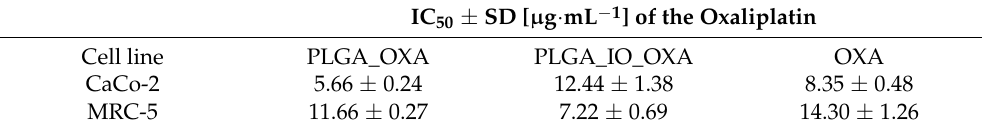
Table 3. Evaluation of in vitro metabolic activity of human cells derived from colorectal carcinoma (CaCo-2) and human primary fibroblasts (MRC-5) treated with PLGA_OXA and PLGA_IO_OXA for 72 h determined by WST-1 assay. IC 50 —concentration of the oxaliplatin (free—OXA, and in the nanoparticles) required to achieve 50 % reduction in cell viability; SD—standard deviation (from four replicates).